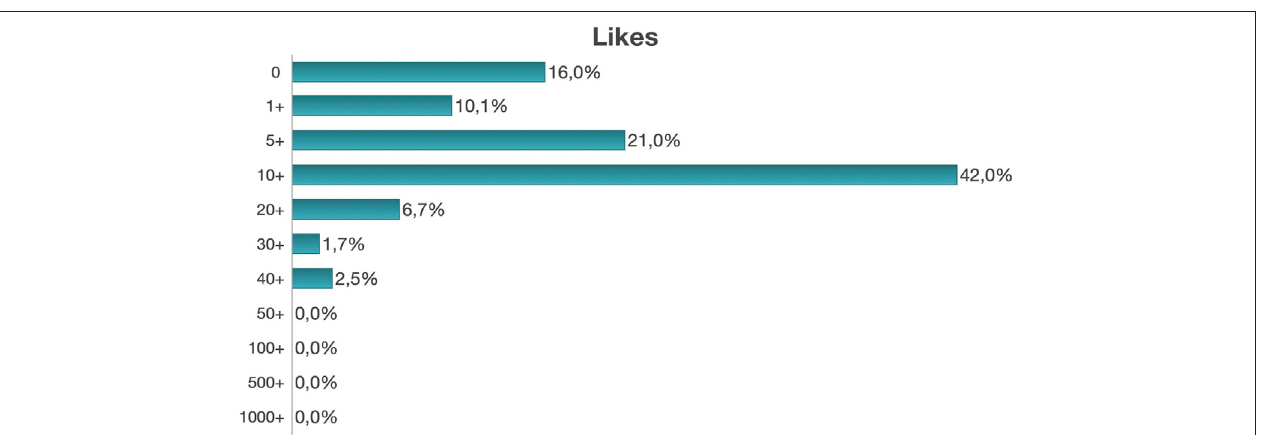
FIGURE 4 | Volume of likes of the Congo Check Twitter posts.